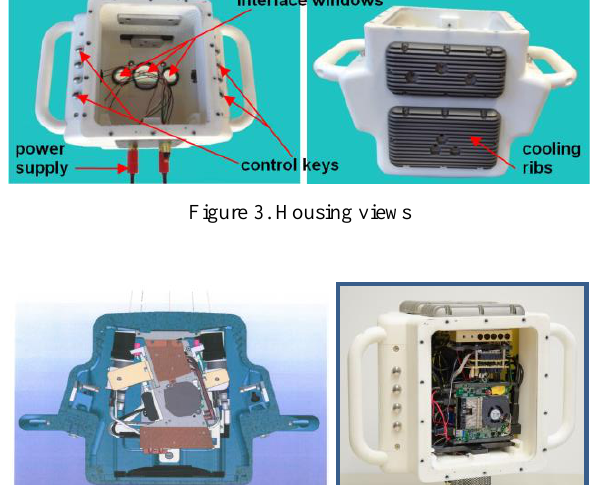
Figure 5. Ray directions using spherical dome ports